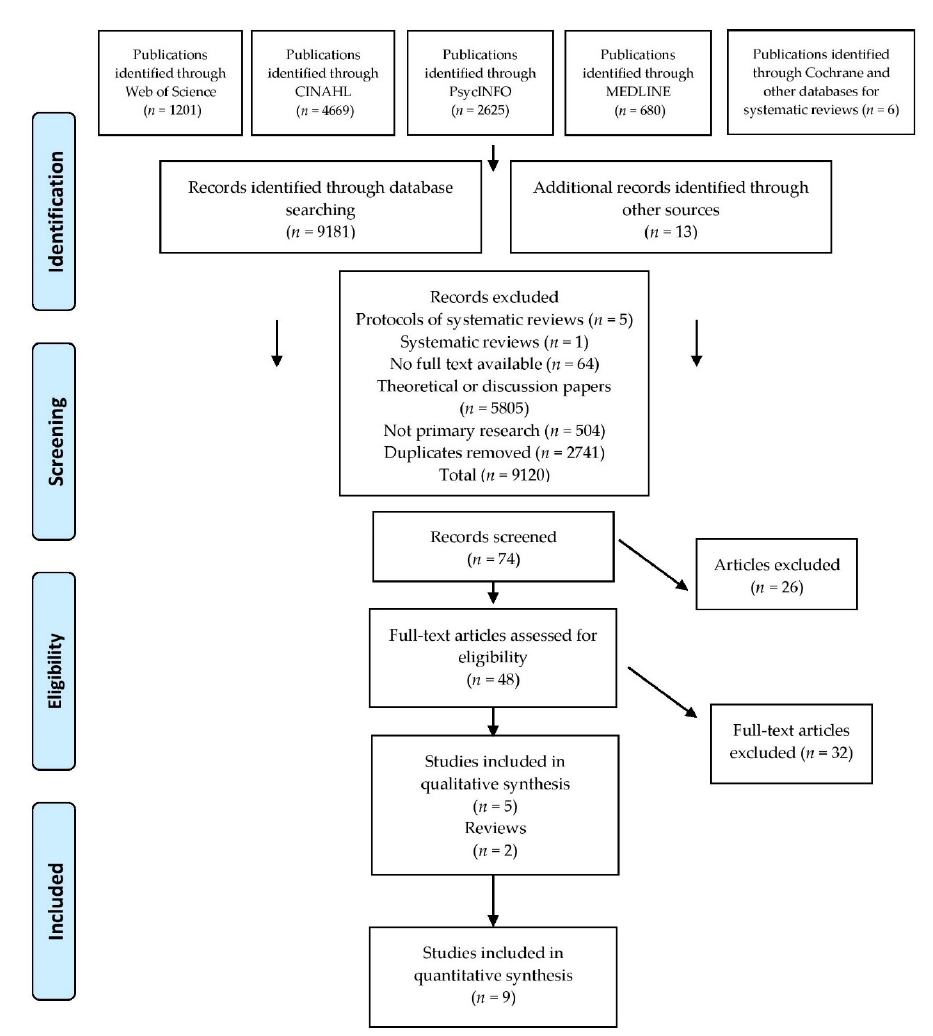
Figure2. Figure 2. Preferred Reporting Items for Systematic Reviews and Meta-Analyses (PRISMA) flow diagram.